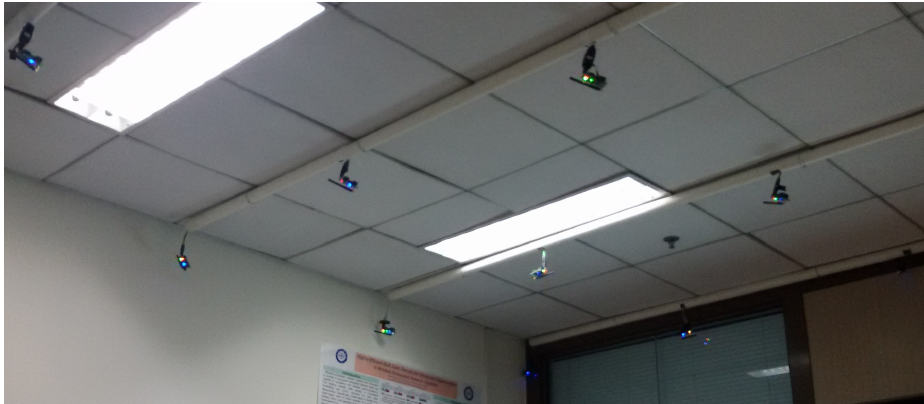
Figure 6. NGMI’s ceiling: Part of the 4 × 5 WSN testbed.